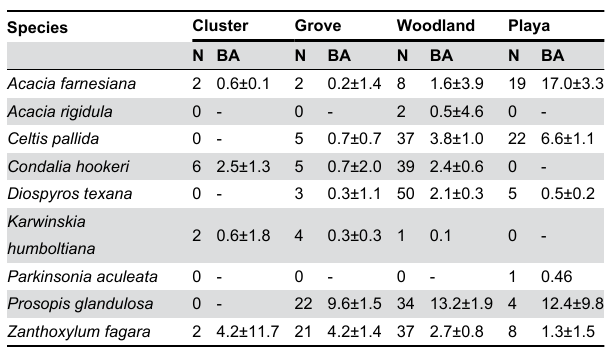
Table 2. Occurrence of tree-stature species (> 5 cm basal diameter) within 6 × 6m contiguous plots along a transect spanning shrub cluster and grove communities in savanna parkland uplands, woodlands of intermittent drainages, and a playa (Figure